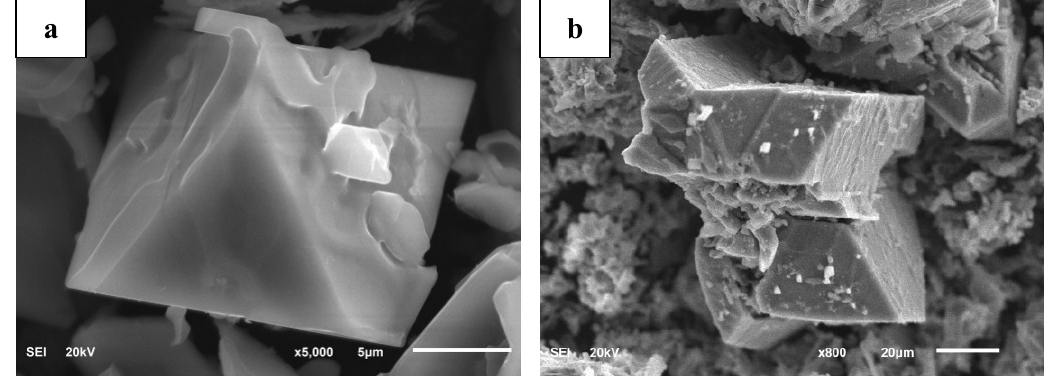
Figure 4. Different morphologies of FSM master alloy modified primary Si: ( a ) octahedron; ( b ) star-like polyhedron.